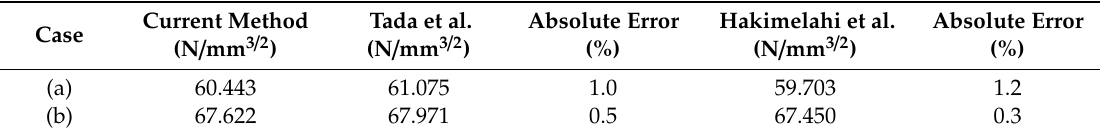
Table 4. Comparison of SIF values using present method with [26,28].